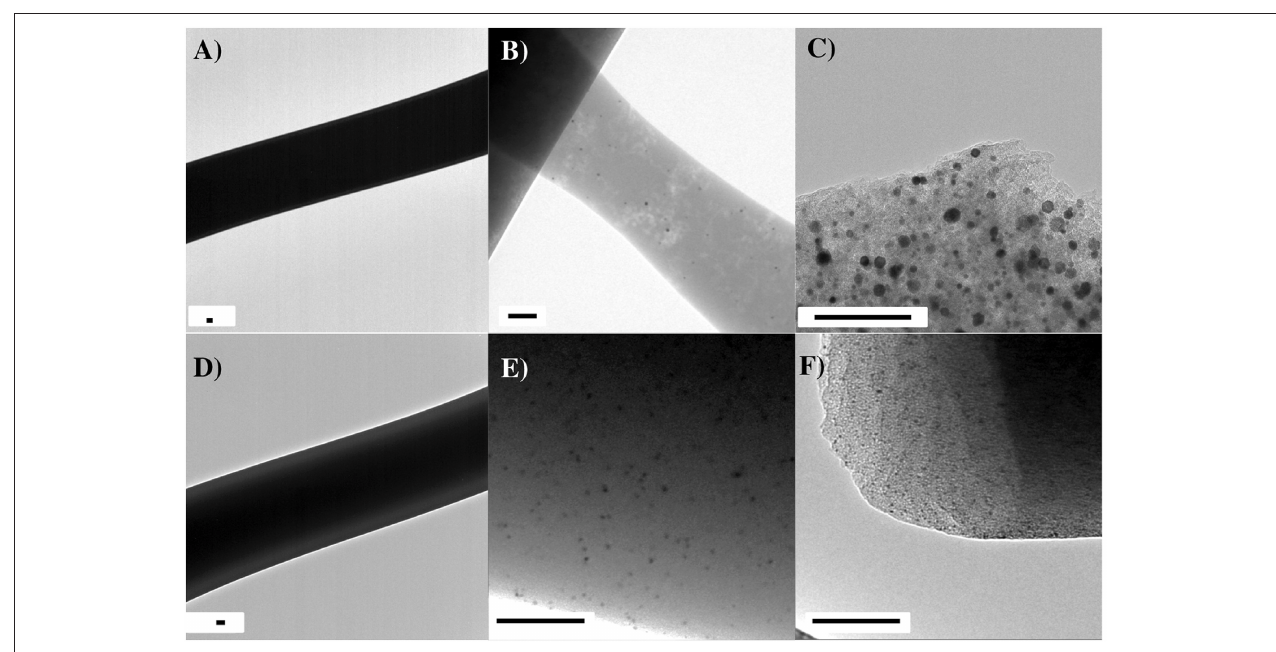
FIGURE 8 | TEM images of Pt-containing carbon fibers (A–C) CFs; and (D–F) PCFs. Bar scale: 100nm.